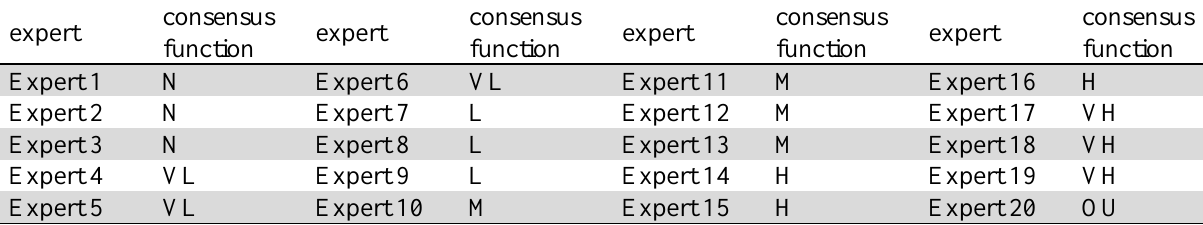
Consensus function of each